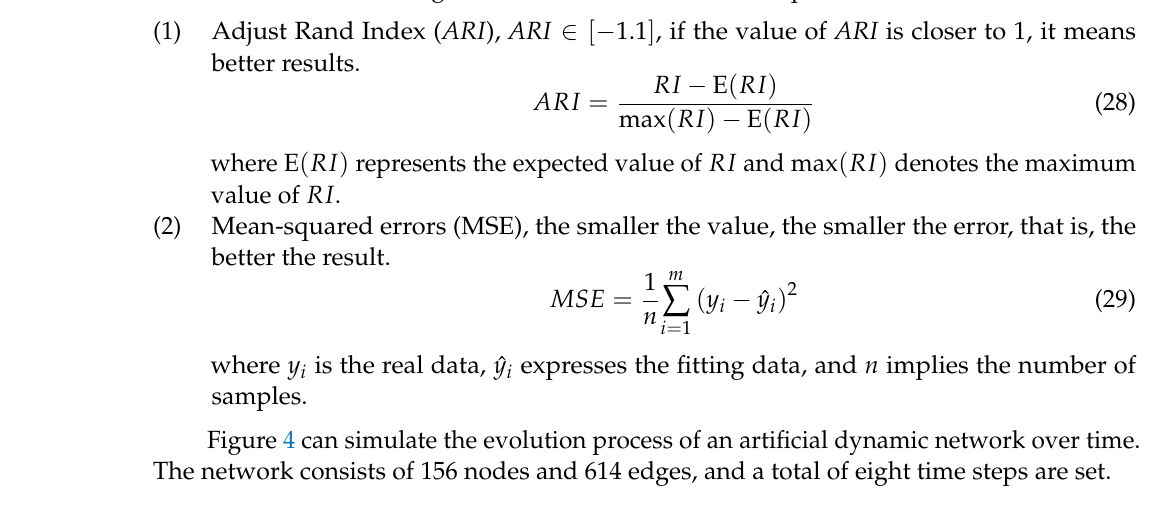
Figure 4 can simulate the evolution process of an artificial dynamic network over time.